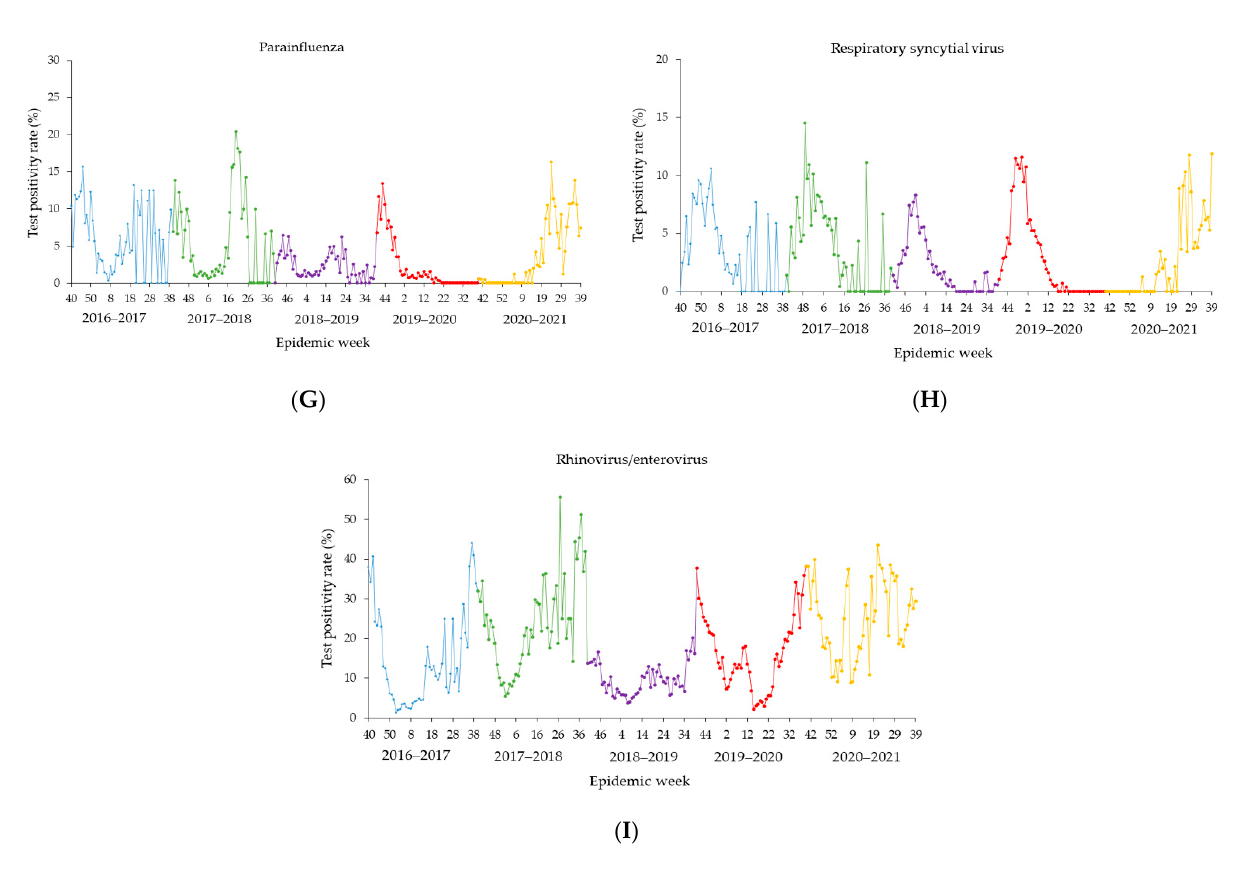
Figure 1. ( A – I ) Weekly test positivity rate of seasonal respiratory viruses over five respiratory seasons from 2016–2017 to 2020–2021. Epidemic week is the week of the epidemiologic year for which there is the National Notifiable Diseases Surveillance System (NNDSS) disease report, the United States. Table 2. Characteristics of seasonal pattern of influenza activity over five respiratory seasons